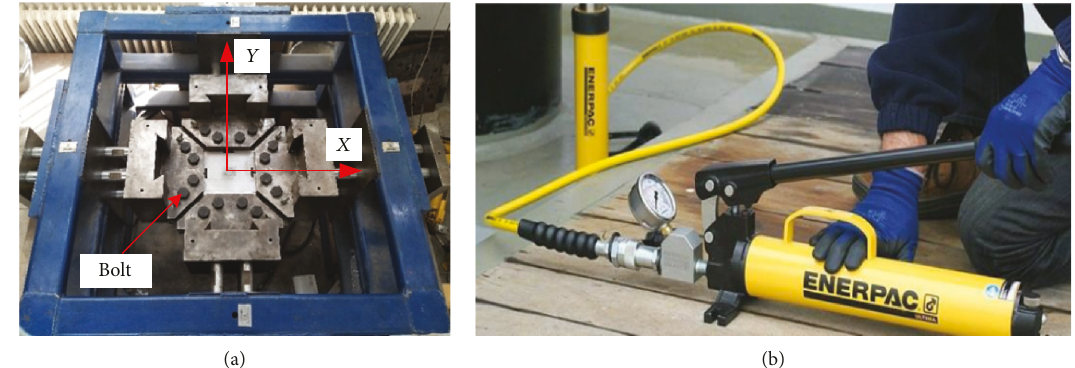
Figure 11: Biaxial tensile tester. (a) Biaxial stretching device. (b) Pressurization